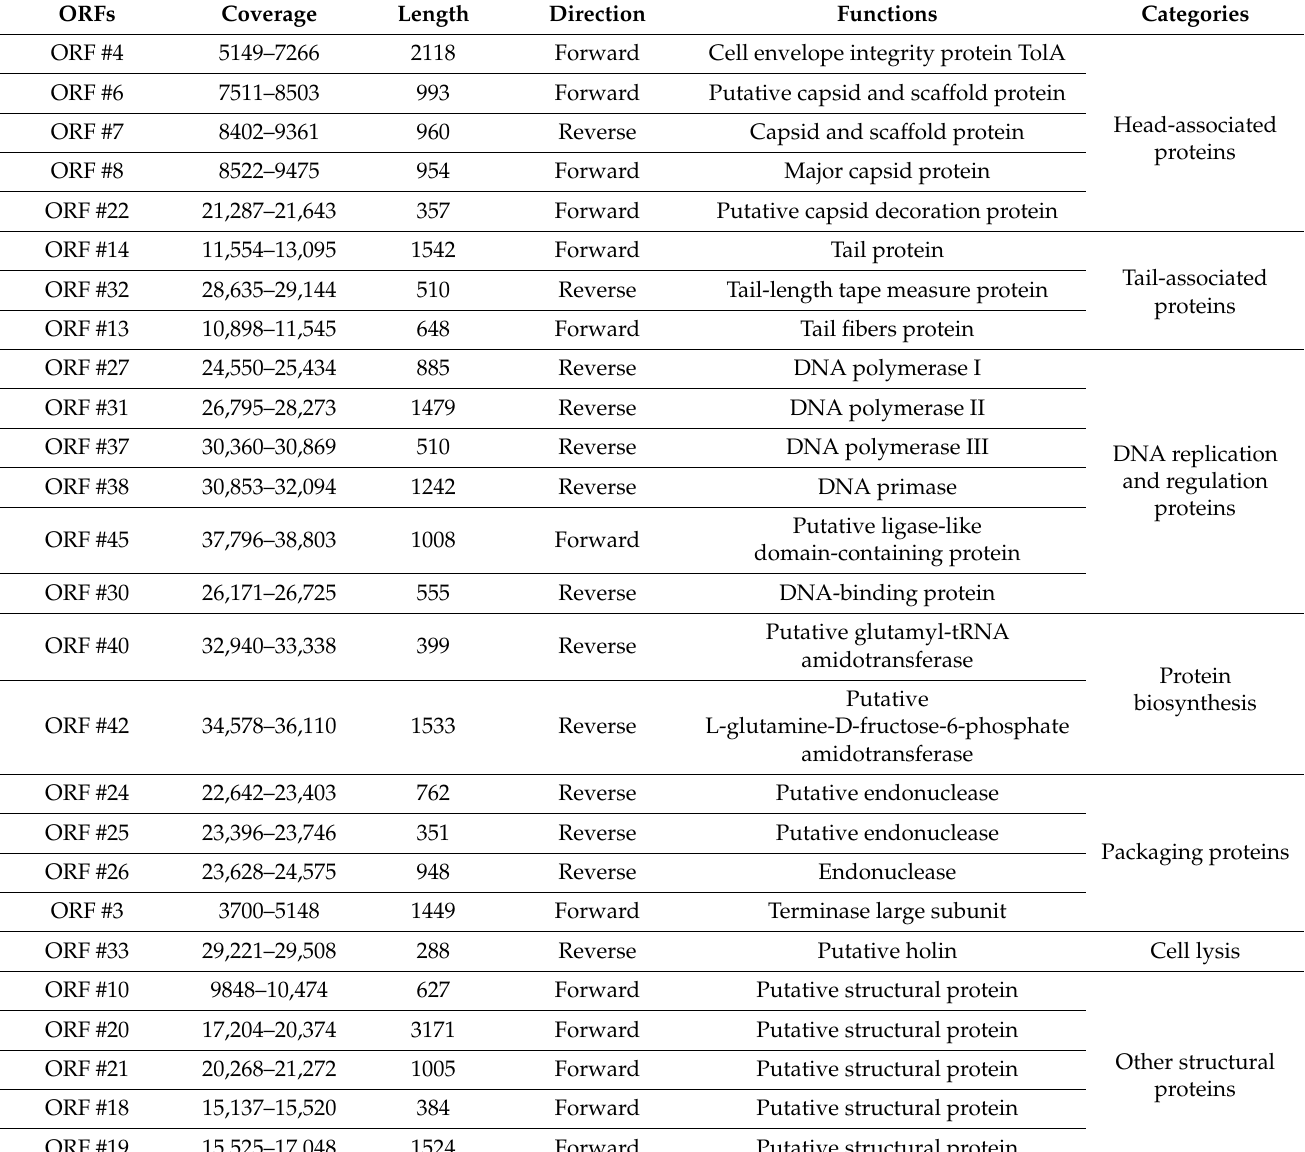
Table 2. The annotated functional ORFs of